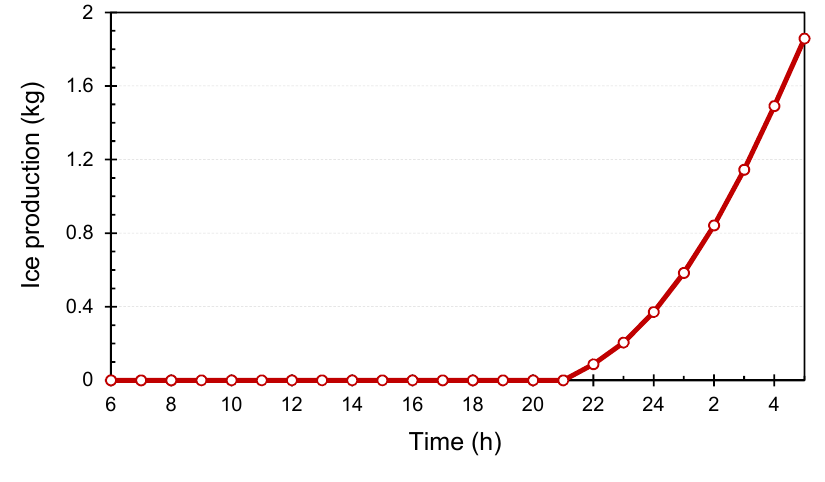
= L =1.25 m, and L cpc,E cpc,W